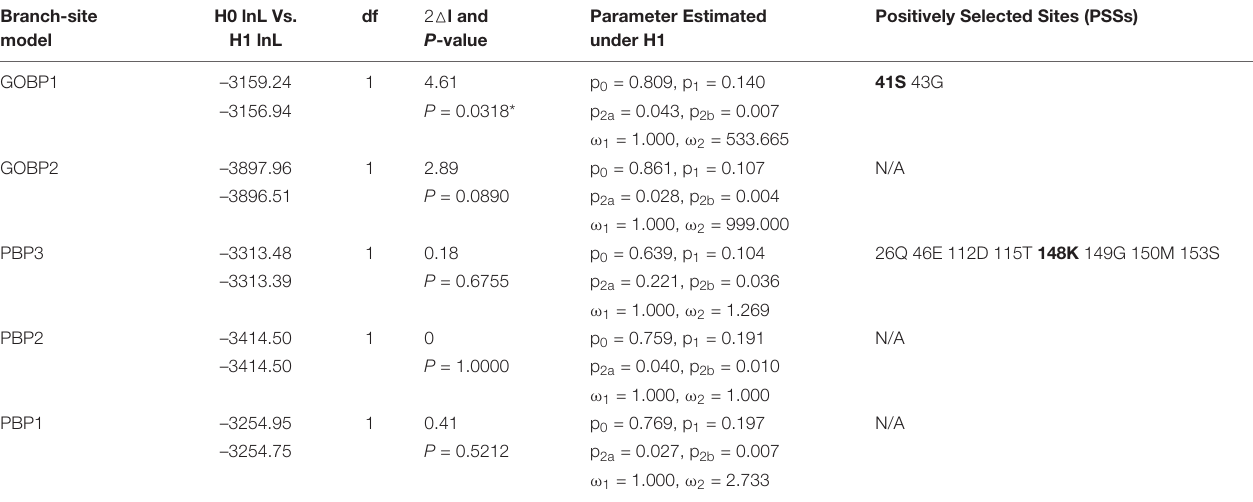
TABLE 2 | Tests of positive selection on Lepidopteran GOBP and PBP genes by branch-site model (Branch labels referring to Figure 5 ). Branch-site model